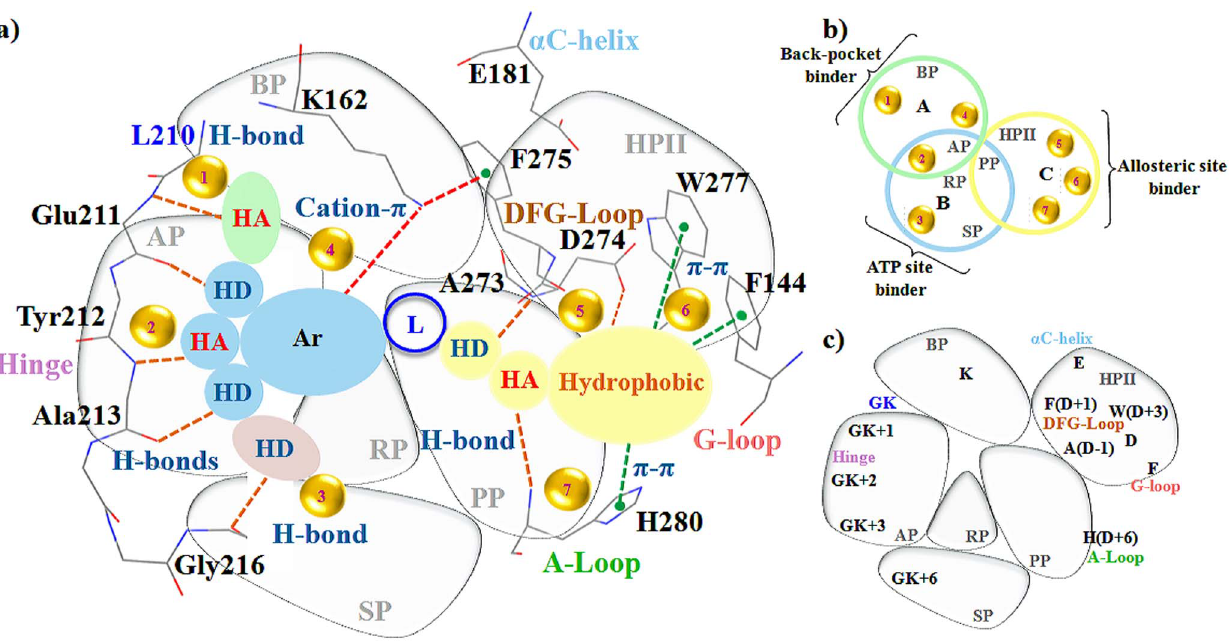
Figure 5. Non-covalent interactions based specificity rendering hot-spots for the design of Aurora kinase inhibitors. The AK binding site has been partitioned into six sub-pockets namely back-pocket (BP), adenine-pocket (AP), sugar-pocket (RP), phosphate-pocket (PP), solvent-pocket (SP) and hydrophobic allosteric-pocket (HPII). All possible pharmacophore features found in different classes of AK inhibitors have been mapped onto these six sub- pockets. The pharmacophore features constitute the H-bond donor (HD), H-bond acceptor (HA), aromatic moiety (Ar), linker (L) and HPII binder (hydrophobic). The Venn diagram shows intersections of the six sub-pockets and hot-spots. The colour of the ring represents the pharmacophore endeared by different sub-pockets. The cartoon representation of the binding-site sub-pockets shows the key interacting residues occupying each sub-pocket. The seven hot-spots highlight the possible non-covalent interactions formed by the key interacting residues of each sub-pocket with different pharmacophore features to achieve specificity.